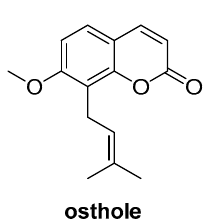
Figure 37. Structure of the natural coumarin osthole.